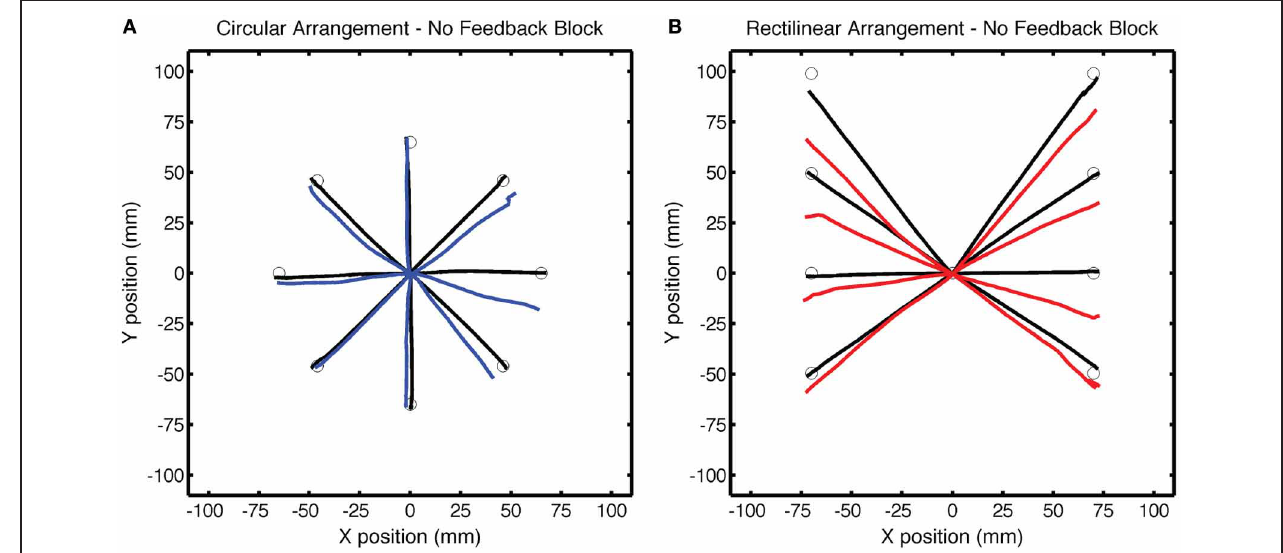
FIGURE 5 | Group averaged trajectories during the No Feedback block in Experiment 1 for the (A) CircleRotation group (blue) and (B) LineTranslation group (red) compared with the